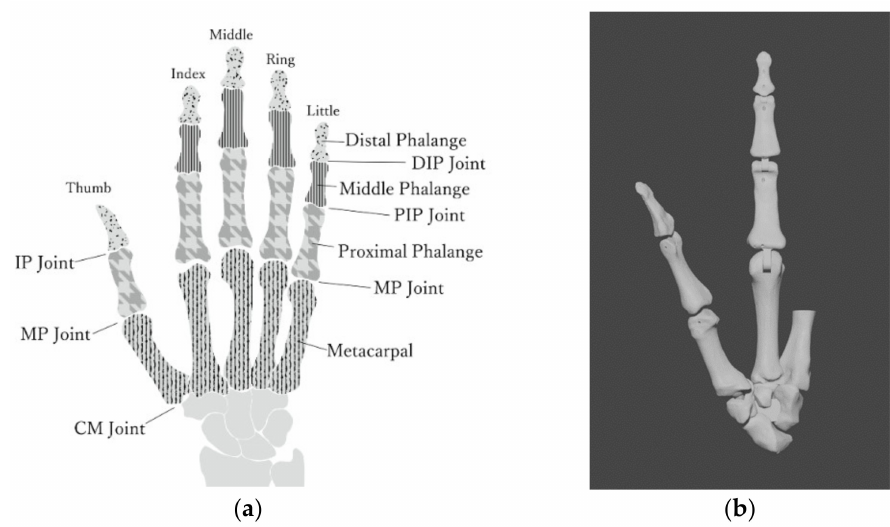
Figure 1. Hand anatomy: ( a ) joint and phalanges of the hand; ( b ) adjusted 3D bone model (thumb and index) using Japanese standard female data.